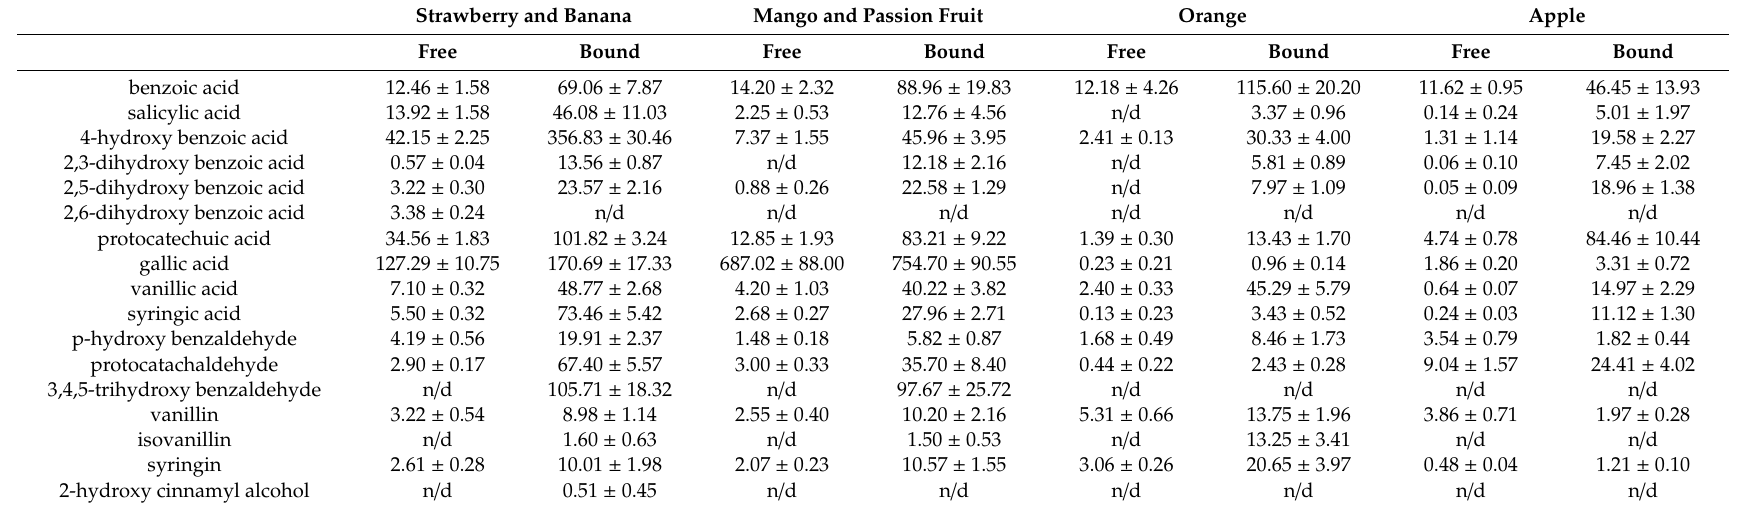
Table 1. Benzoic acid derivative content of juice / smoothie